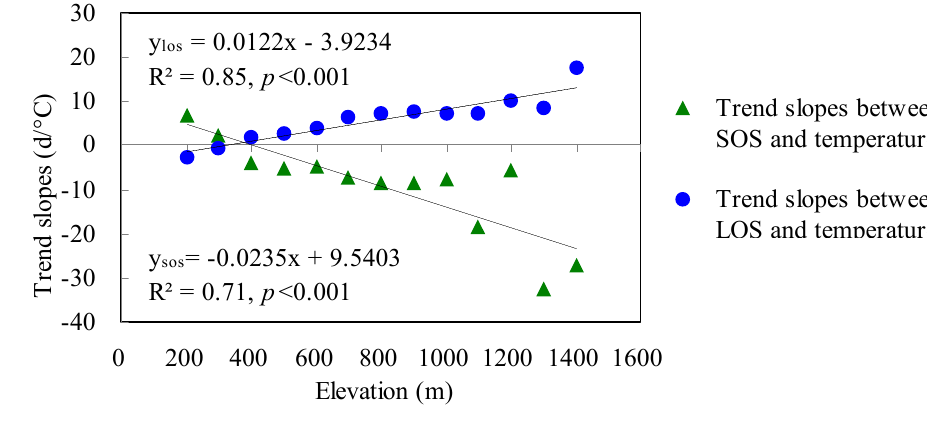
Figure 4. The trend slopes of phenological variables with temperature as a function of elevation.